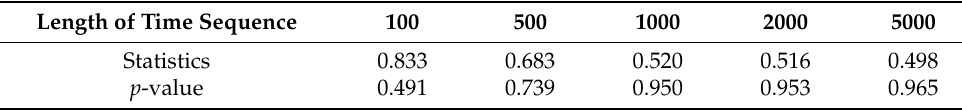
Table 3. The KS Test on the GC Difference Time